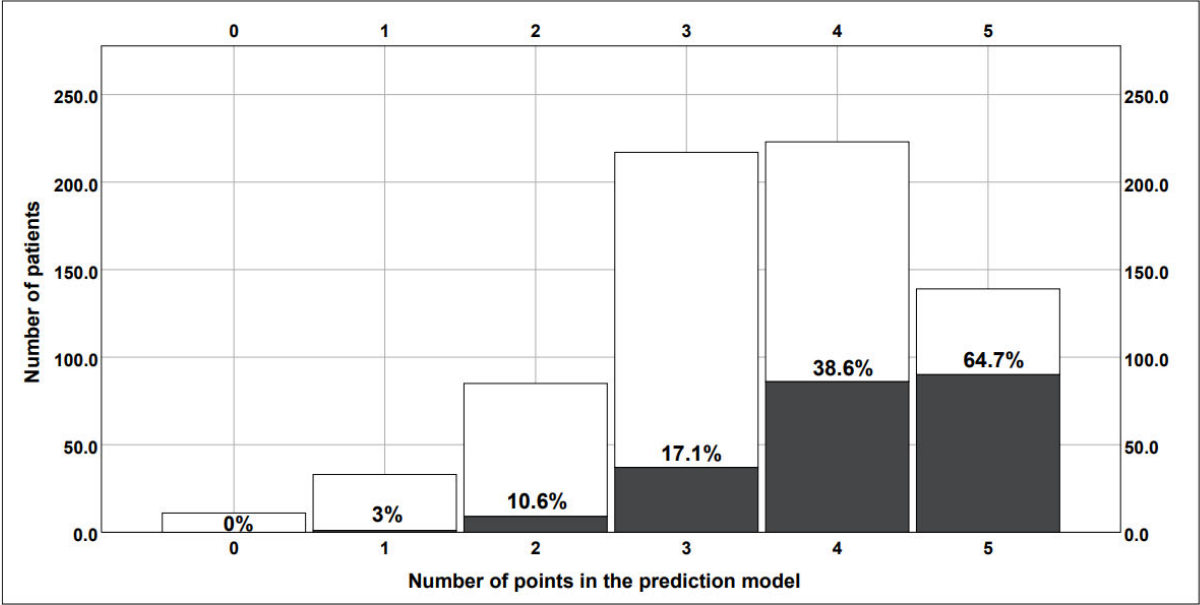
Figure 3. Risk prediction model for the need of DC in SAH patients based on four independent predictors from the multivariate analysis (see Supplementary Materials Table S5): SEBES grade 3–4, ventricular ratio <0.559, WFNS grade 4–5 and Fisher’s grade 3–4. With every point increase in this score, the probability for the need for DC increases. Grey = percentage of patients in need of DC out of all patients with the same score (white ones).